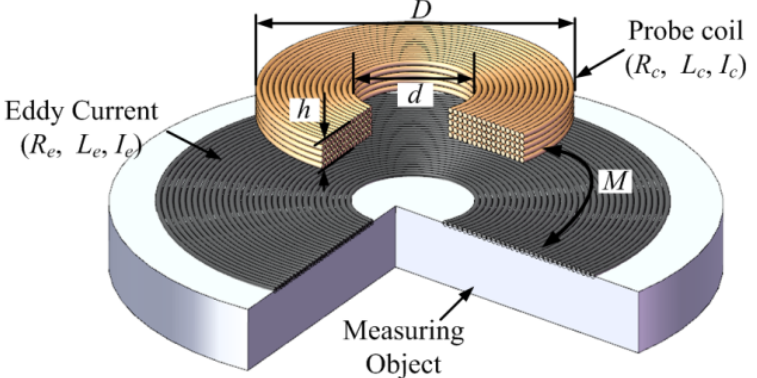
Figure 3. The schematic drawing of the basic principle of the ECDS.